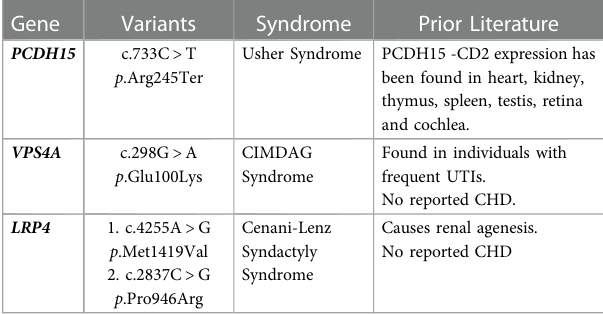
TABLE 3 Potential novel CAKUT/CHD